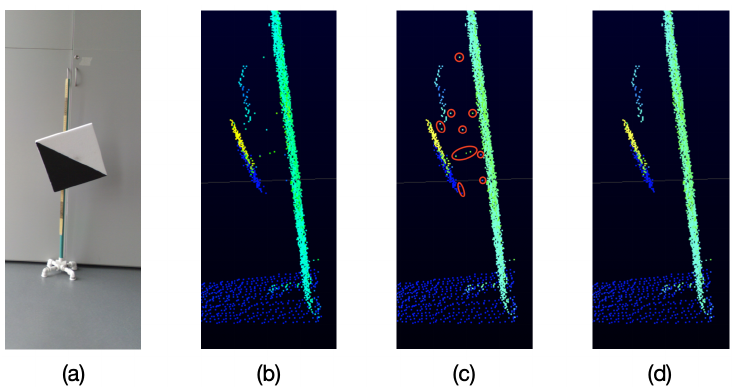
Figure 5. Unwanted points returned by the VLP-16 LiDAR. (a) Object sensed by the LiDAR. (b) Point cloud (side view) returned by the LiDAR. (c) Unwanted points in red. (d) Expected filtered result.